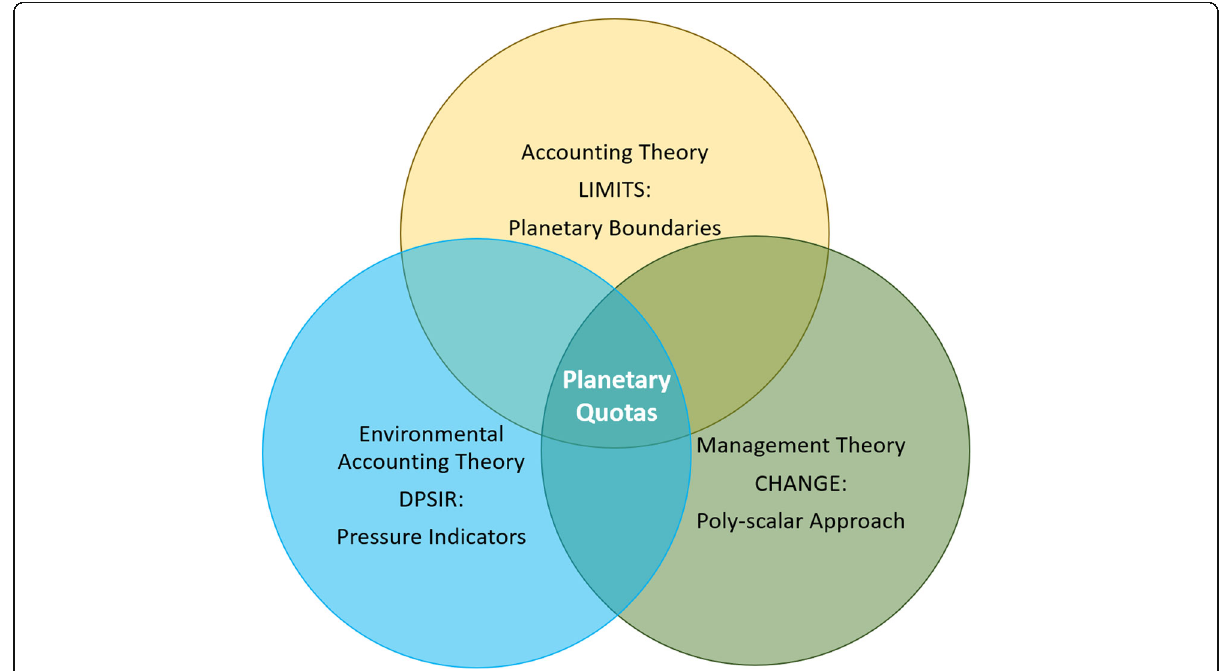
Fig. 1 The Integrated Approach to Developing the Planetary